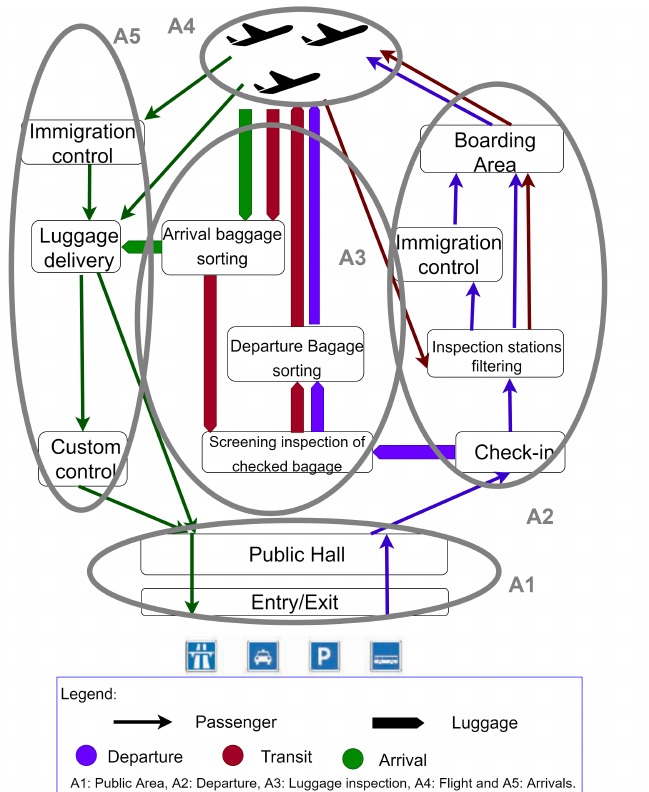
Figure 3. Generic configuration of an airport and its areas of